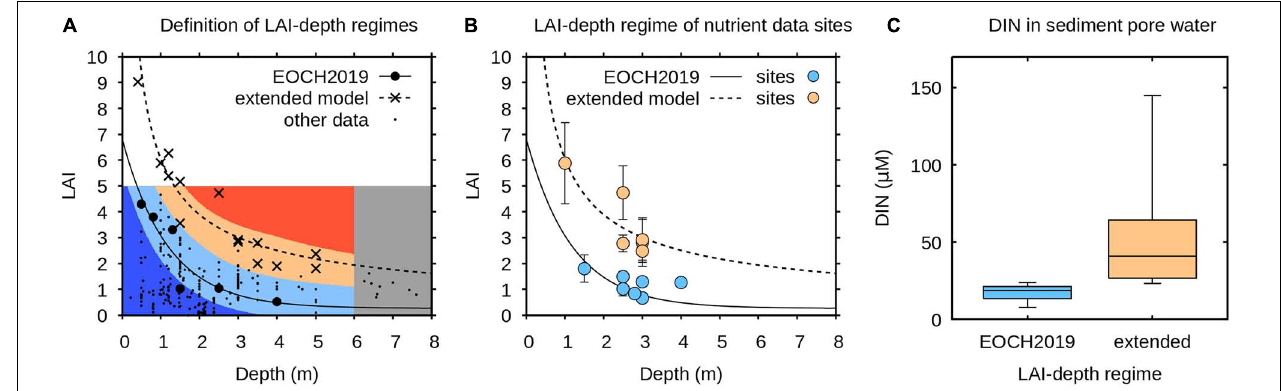
FIGURE 3 | (A) Data on maximum Thalassia testudinum LAI as a function of depth from Enríquez et al. (2019) (EOCH2019) and the extended model (Velázquez-Ochoa and Enríquez, unpublished data). Lines are least-squares fit to the data of an exponential and power model, respectively (Eqs. 1 and 2). Small dots show all depth and LAI determinations ( n = 244). Background colour is as used in results figures. (B) LAI and depth of sites for nutrient determination. (C) Dissolved inorganic nitrogen (DIN) in the sediment pore water at the sites shown in (B) , box plots show median, quartiles and range, medians are significantly different with p < 0.01 (Mann-Whitney U